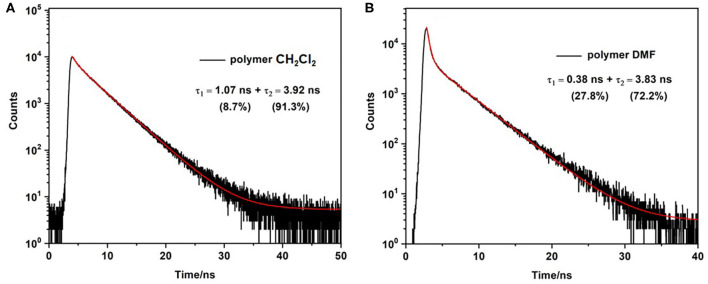
Emission decay of polymer in CH2Cl2
(A) and DMF (B) obtained using FLS1000 Photoluminescence spectrometer λexc = 510 nm. All solutions purged with N2 for 20 minutes prior to sample measurement.